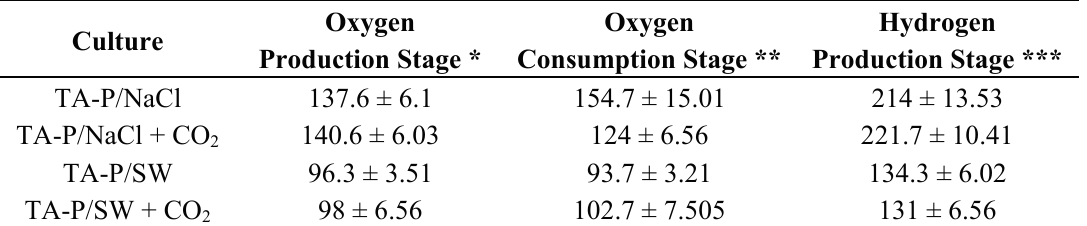
Table 1. Duration in hours of different stages of Chlorella sp. adaptation to